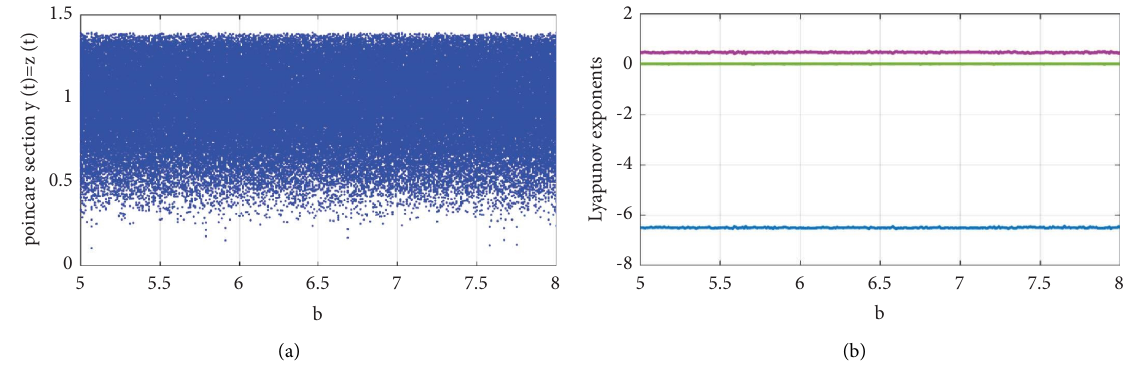
Figure 7: (a) Te system bifurcation diagram and (b) the corresponding Lyapunov exponents, utilizing b as the bifurcation parameter with fxing the other parameters constant such that a � 2 ,c � 5 , f � 8 , g � 11 , and r �